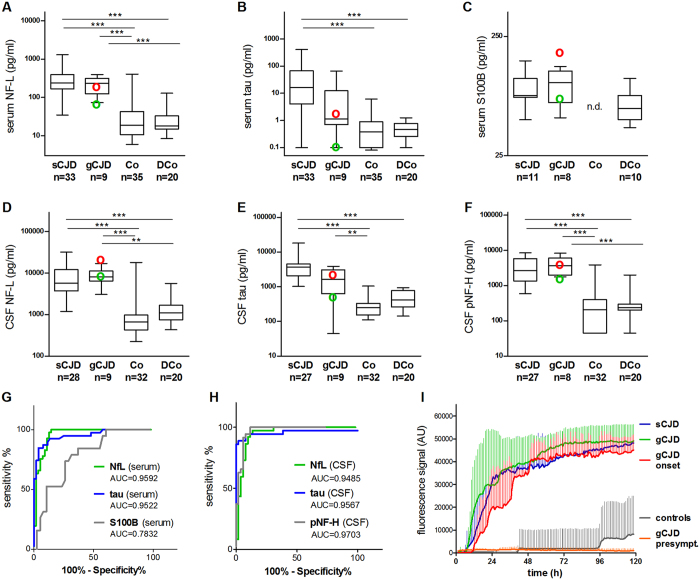
Marker concentrations, ROC diagrams, and RT-QuIC results for CJD and controls.Boxplots show the serum levels of NF-L (A), tau (B), and S100B (C), as well as the CSF levels of NF-L (D), tau (E), and pNF-H (F). Displayed are the results for CJD patients (indicated separately for sCJD and gCJD) and from demented (DCo) and non-demented controls (Co). The concentrations of analytes determined in serum and CSF from a gCJD patient at presymptomatic and early symptomatic disease stage are indicated by green and red circles, respectively. Boxes give median values with interquartile ranges, whiskers indicate the concentration range. Three and two asterisks indicate statistically significant differences of p < 0.0001 and p < 0.01, respectively. The diagnostic performance of markers is illustrated by ROC curves for serum (G) and CSF (H). Except for S100B, of which levels were determined in DCo only, ROC analyses were conducted considering all CJD measures (i.e. sCJD and gCJD) versus all controls (i.e. DCo and Co). The results of RT-QuIC are shown in (I). Displayed are the mean fluorescence signals with SD detected in the CSF of sCJD patients (n = 6), gCJD patients (n = 4), and controls (n = 6). Separately shown are the results for 3 replicate measurements of the gCJD mutation carrier in the asymptomatic disease stage (orange) and at disease onset (red).